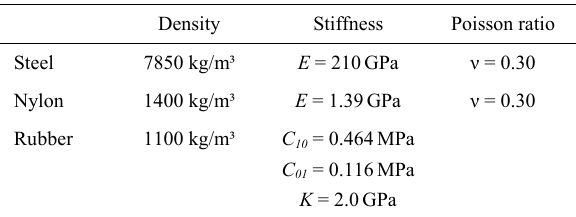
Table 1: Material properties for bias-ply